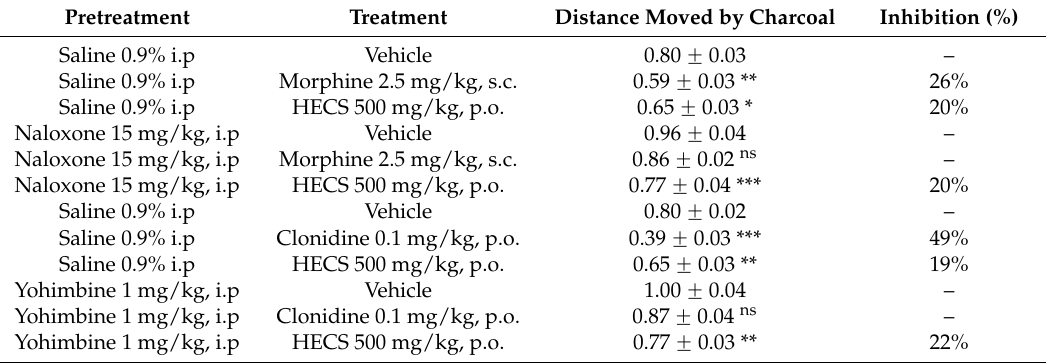
Table 4. Effect of the hydroalcoholic extract of Cissus sicyoides (HECS) on intestinal transit in animals pretreated with naloxone (opioid receptor antagonist) or pretreated with yohimbine ( α 2 -adrenergic antagonist